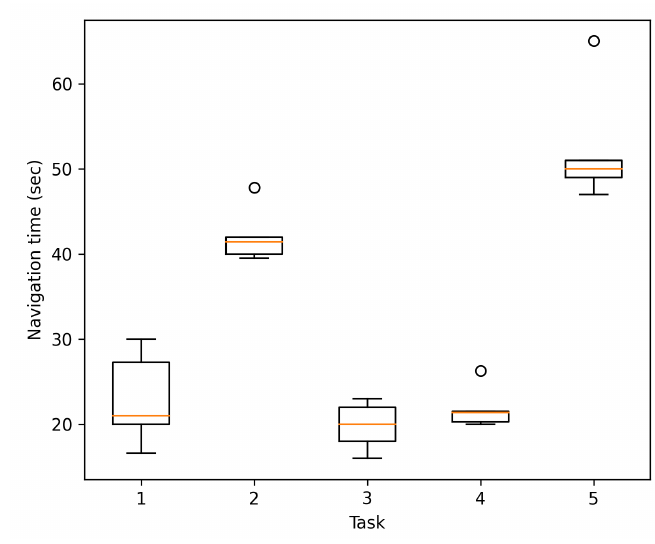
Figure 13. Navigation time per task in the Cinvestav Building.